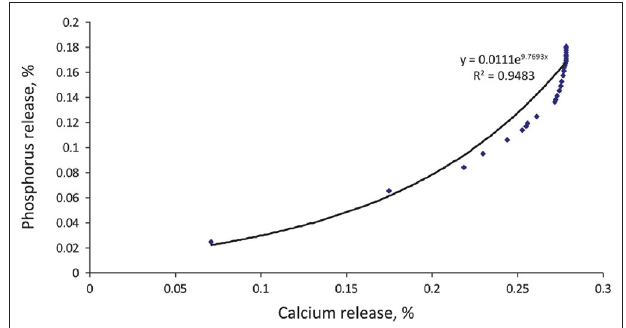
FIGURE 6 | Theoretical relationship between P release from phytate and associated Ca value showing disproportionate extra phosphoric effect with initial destruction of the higher esters